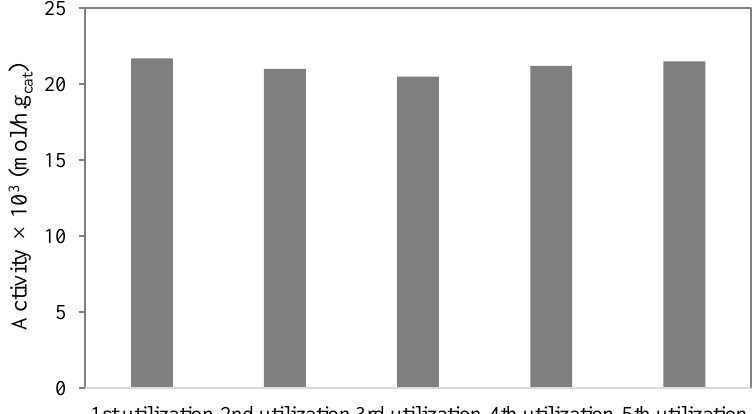
Figure 12. Stability of PW4-K-6 material.